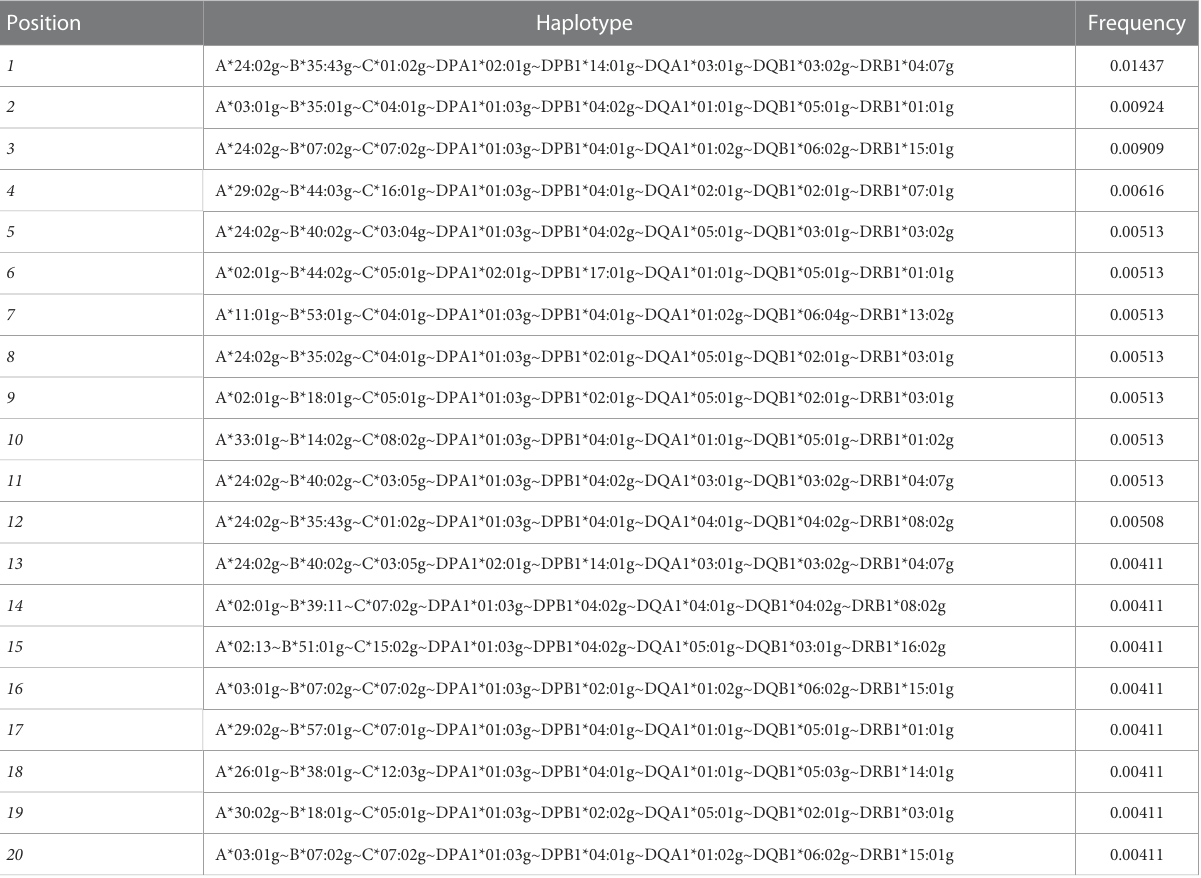
TABLE 7 20 extended haplotypes of the 8 most frequent classic HLA loci.